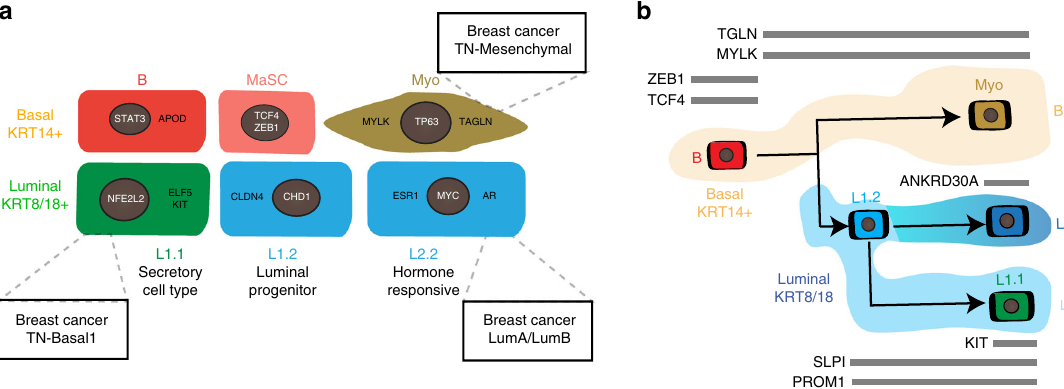
Fig. 7 Proposed cellular heterogeneity and lineage hierarchies within the human breast. a Schematic summary of discovered cell states within the basal and luminal compartment of the human breast epithelium with proposed function, key transcription factors (in white), selected markers (in black) and similarities to breast cancer subtypes indicated in boxes. b Proposed model summarizing the lineage hierarchies within the breast epithelium based on one continuous differentiation trajectory from basal stem cells to three distinct differentiated cell types with overlaid marker genes of interest shown (black on gray bars)